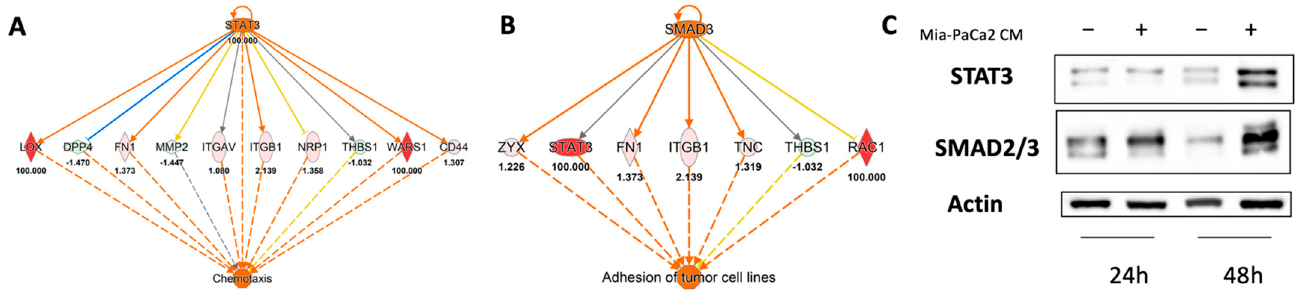
Figure 5. Upstream regulators engaged by 48 h of treatment with MIA-PaCa2 CM. Predicted upstream regulators were STAT3 ( A ) and SMAD3 ( B ). ( C ) Western blot confirming the involvement of STAT3 and SMAD3 as predicted by IPA analysis.